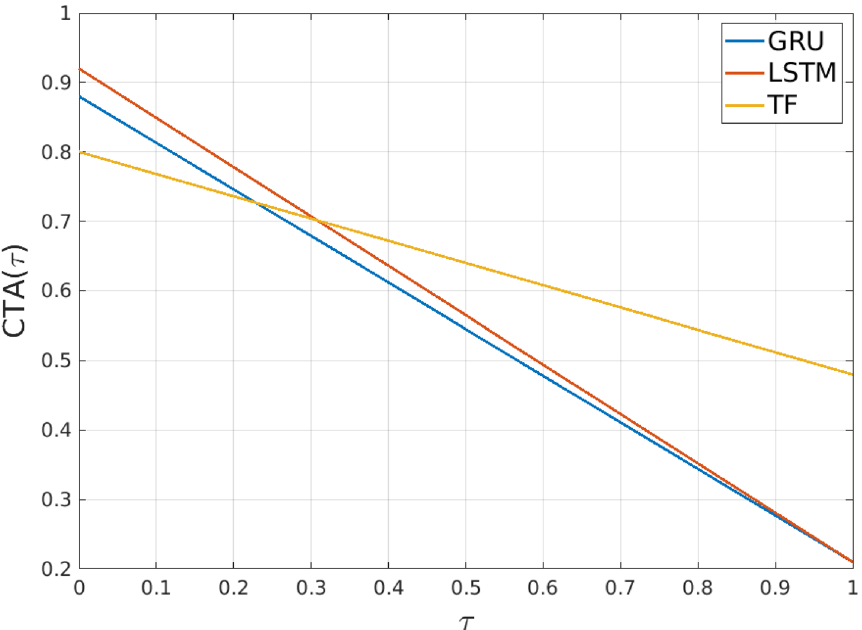
Figure 4. Impact of the weighting parameter τ for the composite time-weighted actions metric. Depicted are the results for GRU, LSTM and Transformer (TF) considering seven actions in the past and predicting seven future actions.